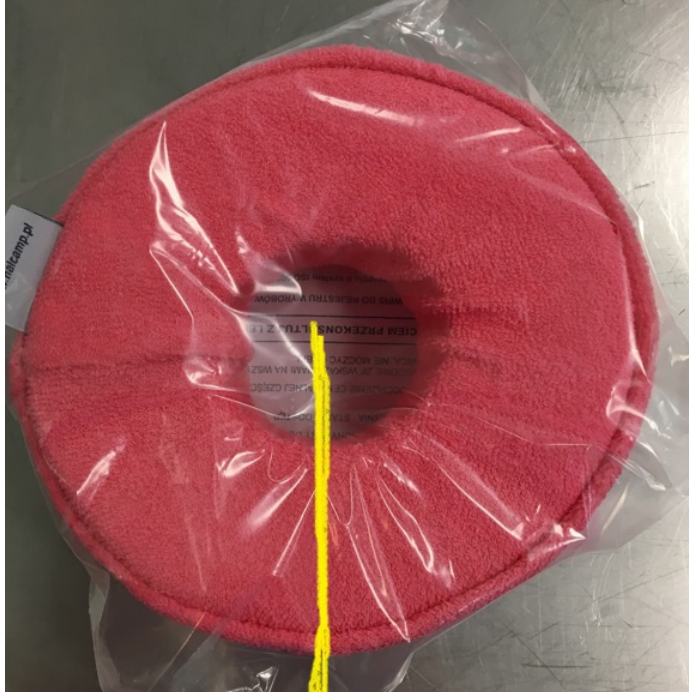
Figure 1. Polyurethane foam with the marked cutting line.